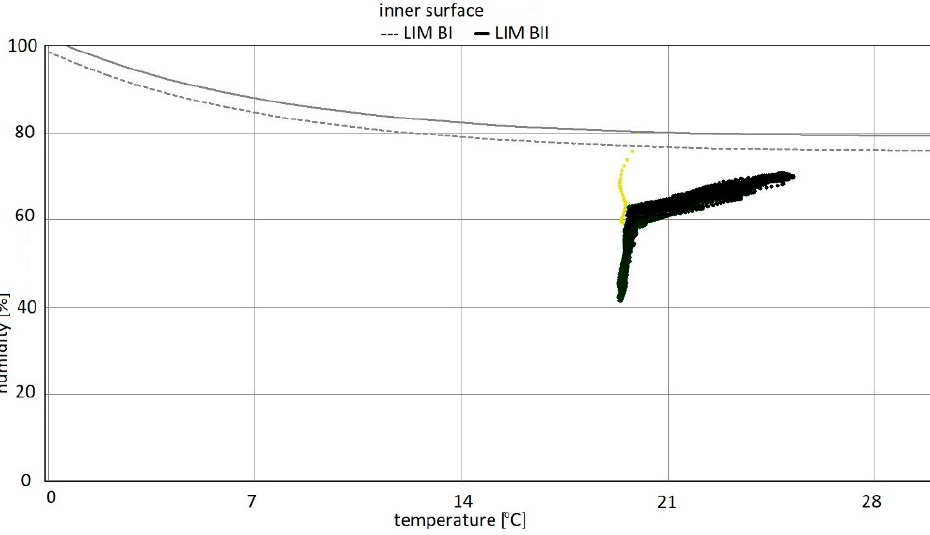
Figure 11. Isopleth of the inner surface of the partition, variants 1–3 [70]. The isopleths of the LIM B I (dashed line) and LIM B II (solid line) curves, i.e., contour charts of the mould growth rate as a function of temperature (horizontal axis) and humid- ity (vertical axis) as shown in the diagram, do not intersect with the area of points for the analysed partition.